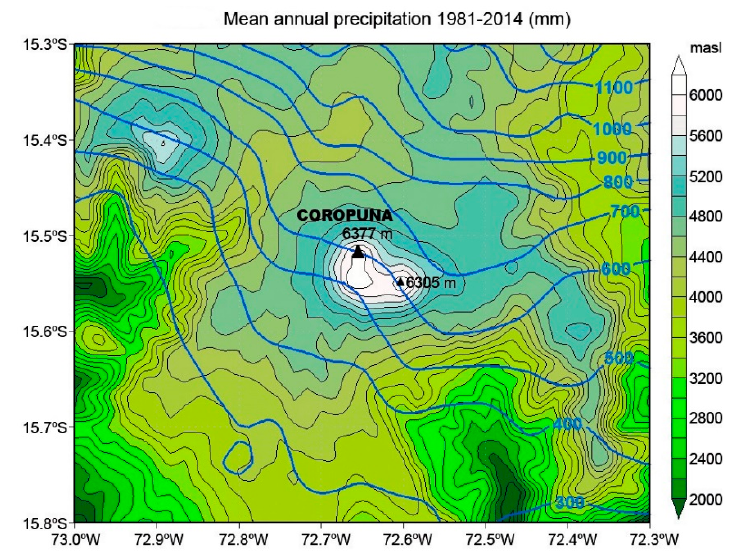
Figure 2. Monthly precipitation averages 1998–2007. Tropical Rainfall Measuring Mission (TRMM ‐ NASA). The black triangles indicate the Coropuna location.